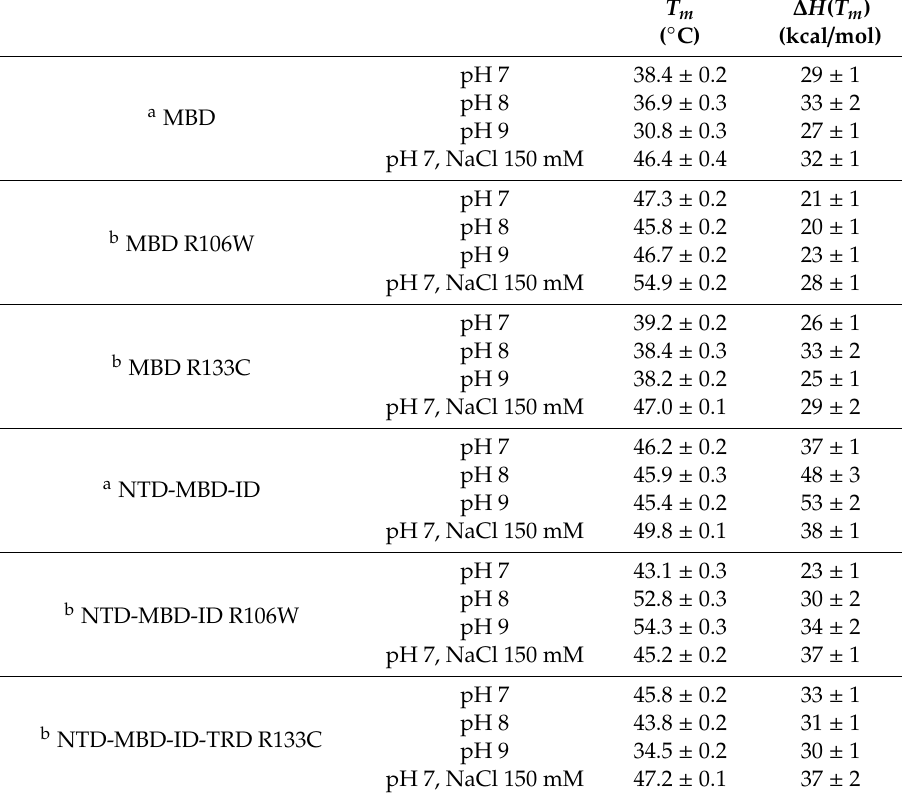
Table 1. Thermal stability of the di ff erent MeCP2 variants under di ff erent